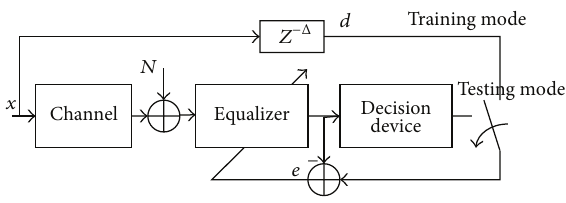
Figure 2: Structure of an adaptive channel